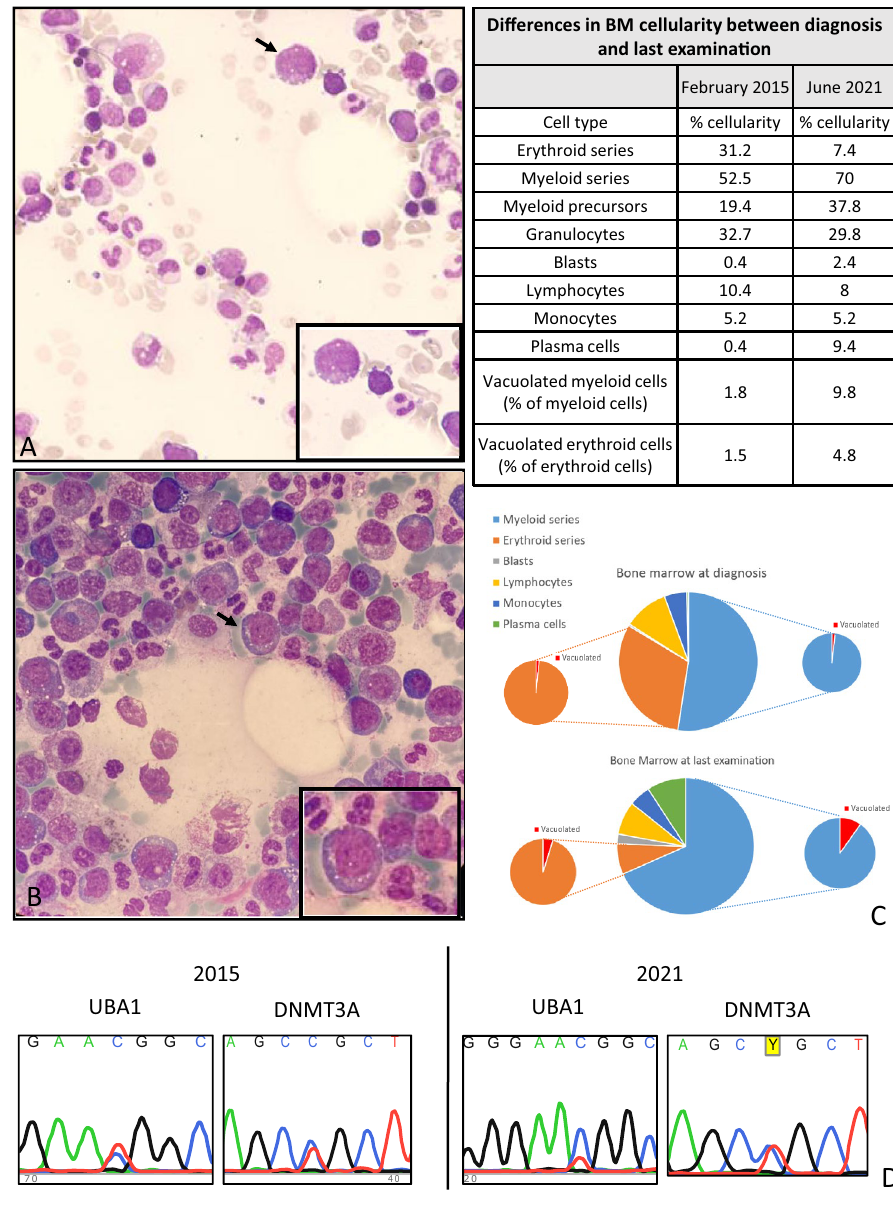
Fig. 2 Laboratory, morphologi- cal and molecular